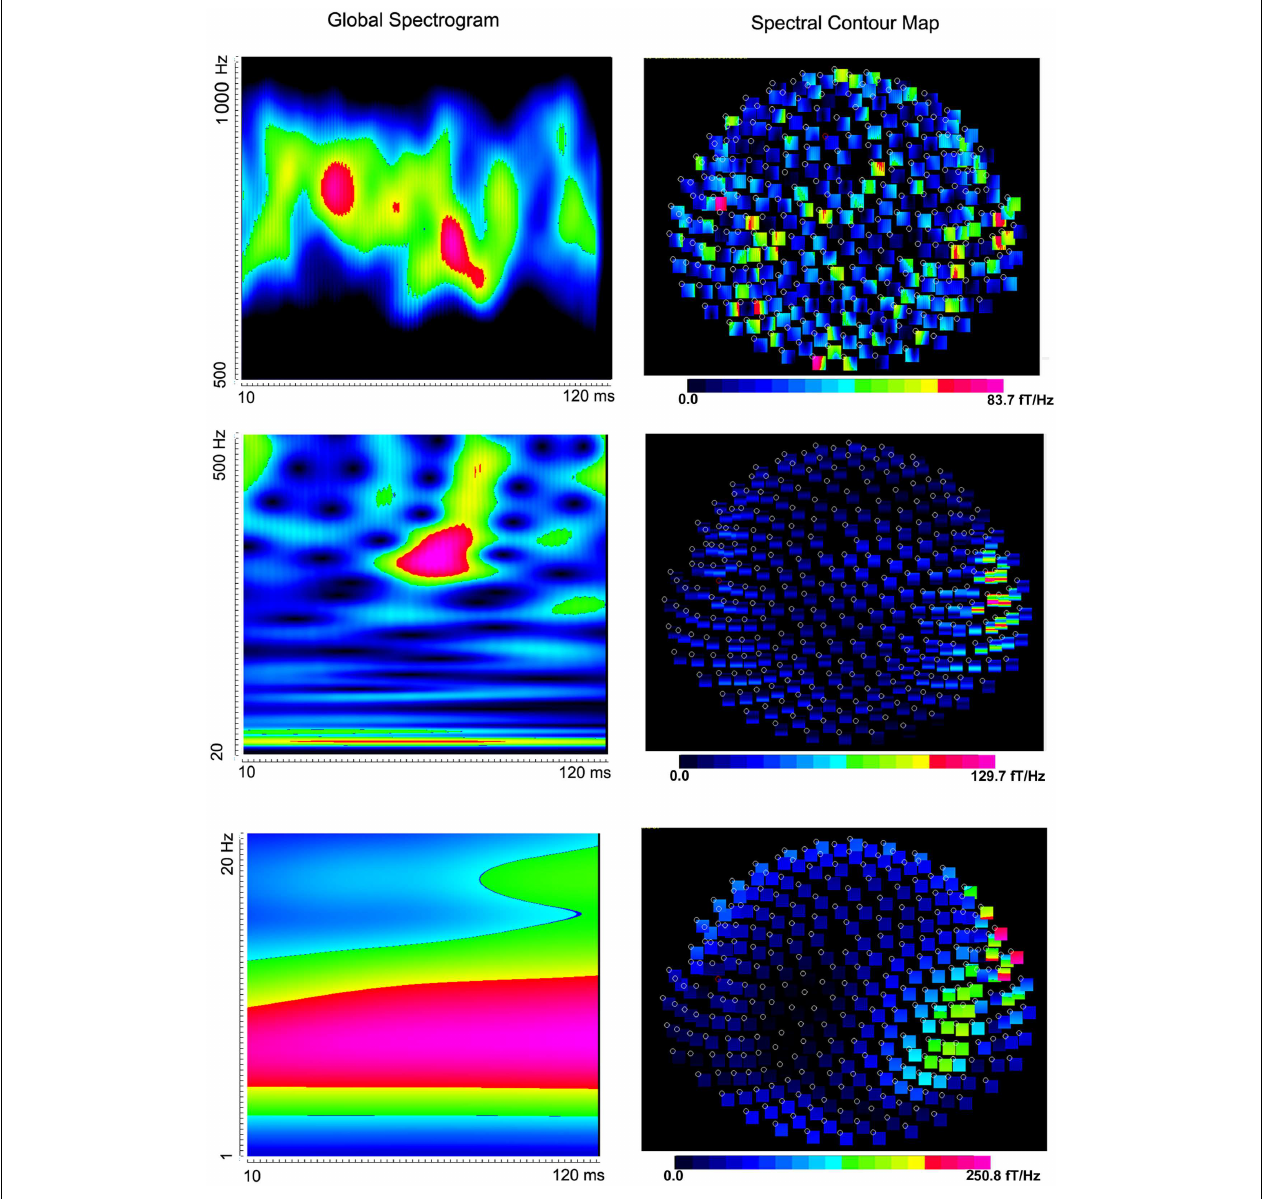
FIGURE 3 | Global spectrograms and contour maps from one subject showing neuromagnetic activation in 1–1000Hz elicited by left finger stimulation . High-frequency spectrograms show precise temporal information while low-frequency spectrograms show precise frequency